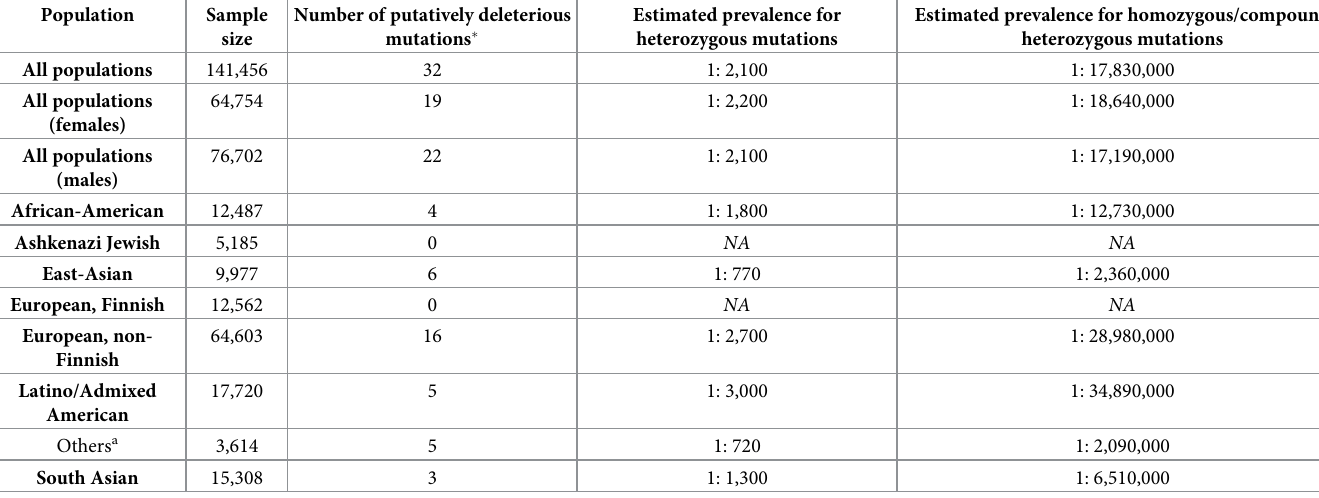
variant located in LEP regardless of the pathogenicity (see Table 2). The prevalence for a homozygous and compound heterozygous variant was ~ 1:14,100 and ~ 1:50,000, respectively. Slightly lower prevalence were detected for variants predicted to be ‘benign’ (see Table 2 and S2 Table). Generally, for indicated pathogenic variants across all populations, if at least one tool predicted pathogenicity, the prevalence of compound heterozygosity is higher than the prevalence of homozygous variants (see Table 2). Further, when applying various pathogenicity definitions based on the number of in silico tools predicting a damaging effect, it is evident that the more stringent this definition, the lower the prevalence (see Table 2). Consequently, we decided to classify variants as ‘patho- genic’ if at least two in silico tools indicated a deleterious impact (definition applied for subse- quent analyses). A total of 67 individuals throughout all populations carried at least one of these variants heterozygously, while no homozygous carriers were detected. Hence, the esti- mated prevalence of heterozygosity for a putatively harmful LEP mutation was approximately 1:2,100, while the prevalence for a homozygous variant was ~ 1:17,830,000 for individuals of all populations (see Tables 2 and 3). Table 3. Estimated prevalence of putatively pathogenic LEP variants for the individual populations in gnomAD. Population Sample Number of putatively deleterious Estimated prevalence for Estimated prevalence for homozygous/compound size mutations � heterozygous mutations heterozygous mutations